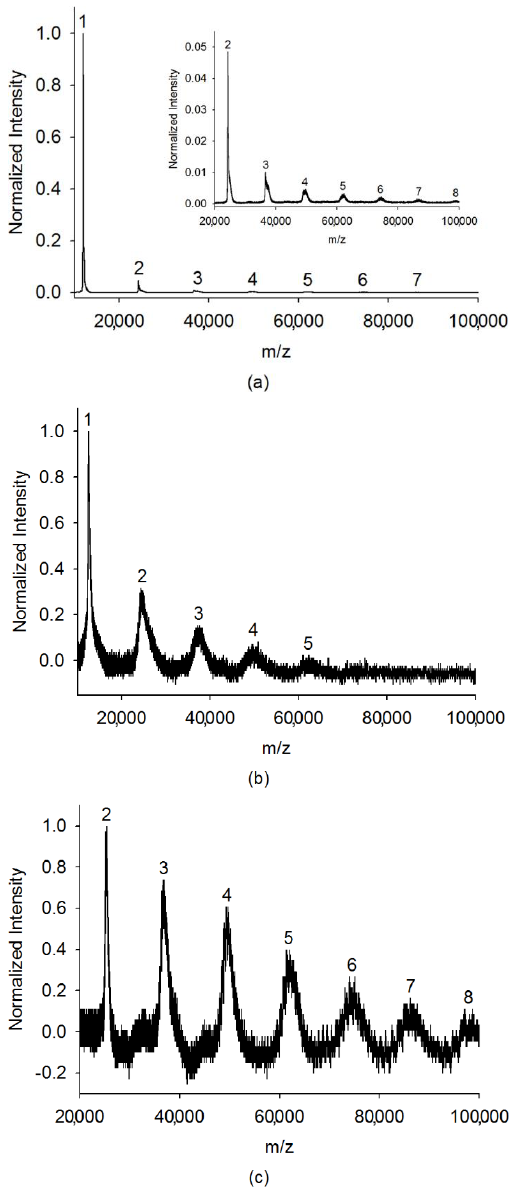
Figure 2. ( a ) Cytochrome c clusters with m / z from 10,000 to 100,000 Da obtained by the Bruker Ultraflex II MALDI-time-of-flight (TOF)/TOF mass spectrometer. The inside box is the magnified mass spectrum for a molecular weight from 20,000 to 100,000 Da. ( b ) Cytochrome c clusters with m / z from 10,000 to 100,000 Da and ( c ) from 20,000 to 100,000 Da obtained by our homemade frequency-scanned quadrupole ion trap (QIT) mass spectrometer with a charge